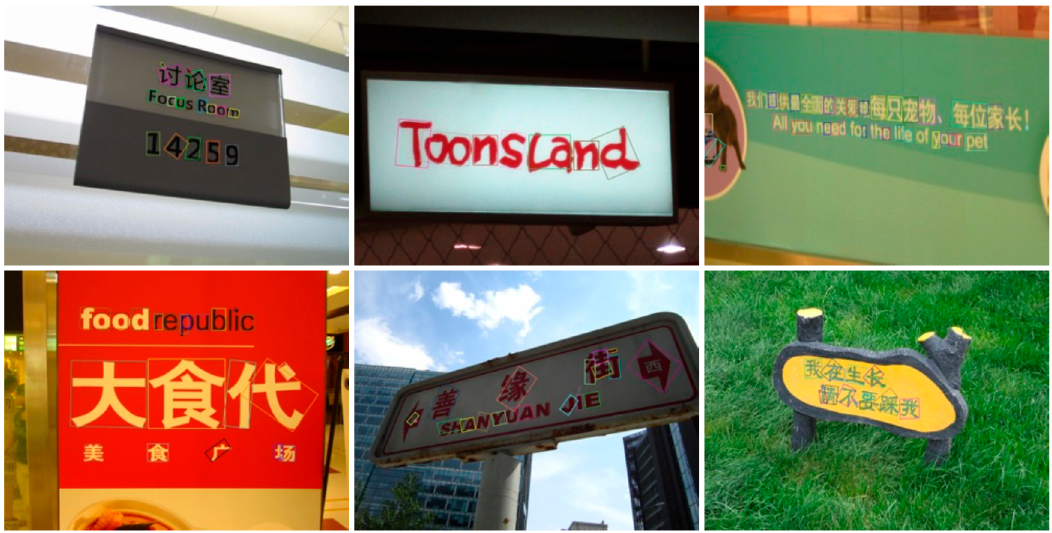
Figure 5. The parsimonious text component set distinguished by the meaningful supervision of the text masks.